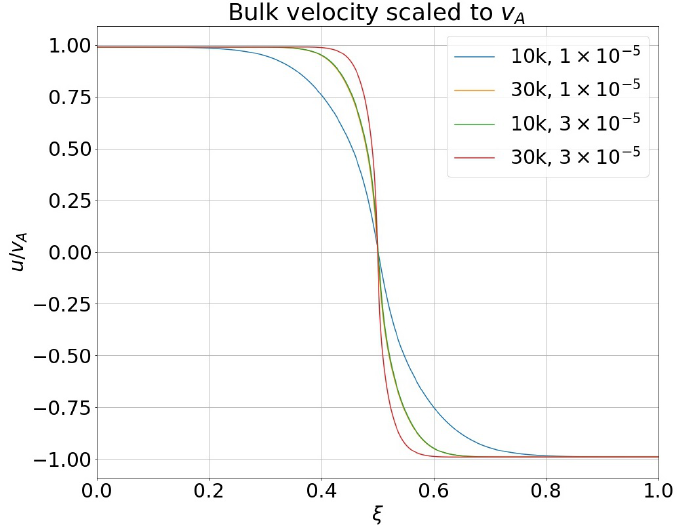
Figure 7. The calculated energetic particle bulk velocities for simulations of coronal loops with the sizes L = 10,000 km and L = 30,000 km. The 30,000 km loop, α = 3 × 10 − 5 simulation has a spatial cell size ∆ x = 5 km and the rest have a spatial cell size ∆ x = 20 km. The loop lengths in kilometers and normalization values for the curves are displayed in the legend in the mentioned